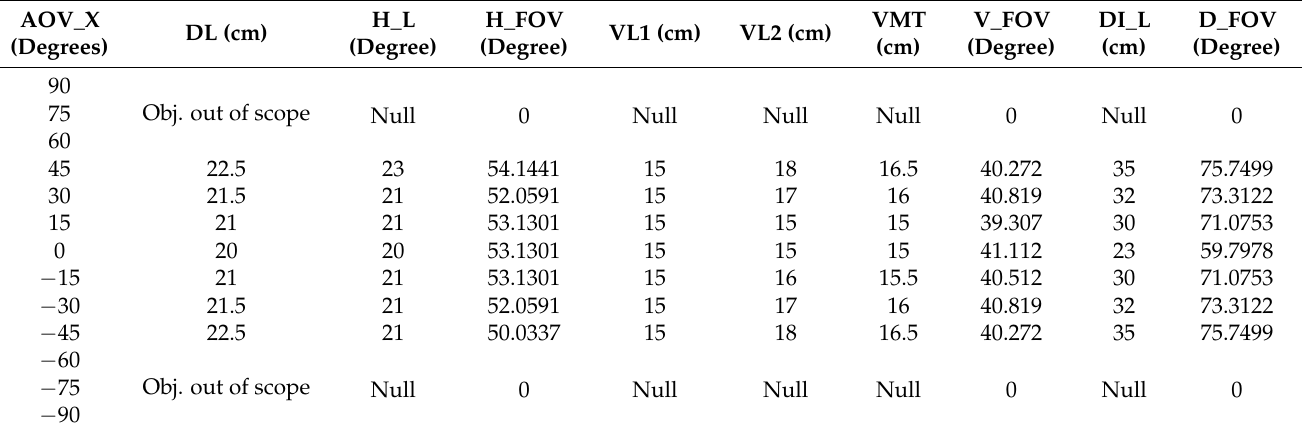
Table 2. Indoor FOV (Filed Of View) measurement over changing the camera angle from − 90 to +90 angle of view on the x-axis (AOV_X), Distance From Lens (DL), Horizontal Length (HL), Horizontal FOV (H_FOV), Vertical Length of Base 1 (VL1), VERTICAL LENGTH of BASE 2 (VL 2), Vertical Median of Trapezoidal Frame (VMT), Vertical FOV (V_FOV), Diagonal Length (DL), Diagonal FOV